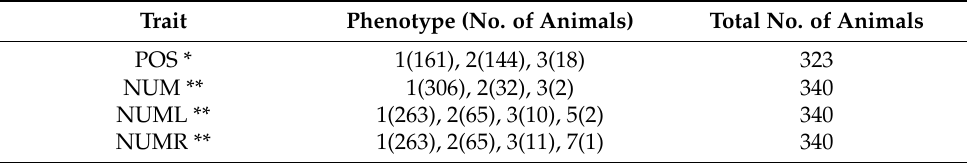
Table 1. Descriptive statistics of hair whorl traits in Quarter Horses. Trait Phenotype (No. of Animals) Total No. of